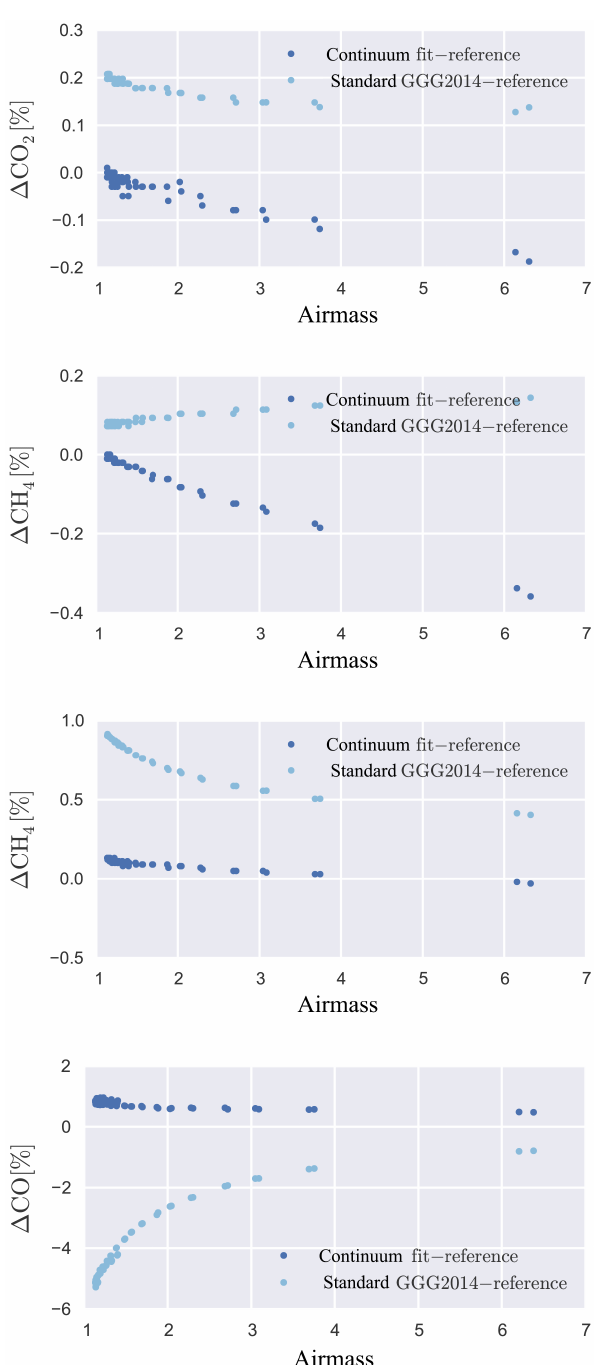
Figure A5. Air-mass dependence for the remaining affected spec- tral windows: first panel, CO 2 (cw: 6339.5); second panel, CH 4 (cw: 5938.0); third panel, CH 4 (cw: 6076.0); fourth panel, CO